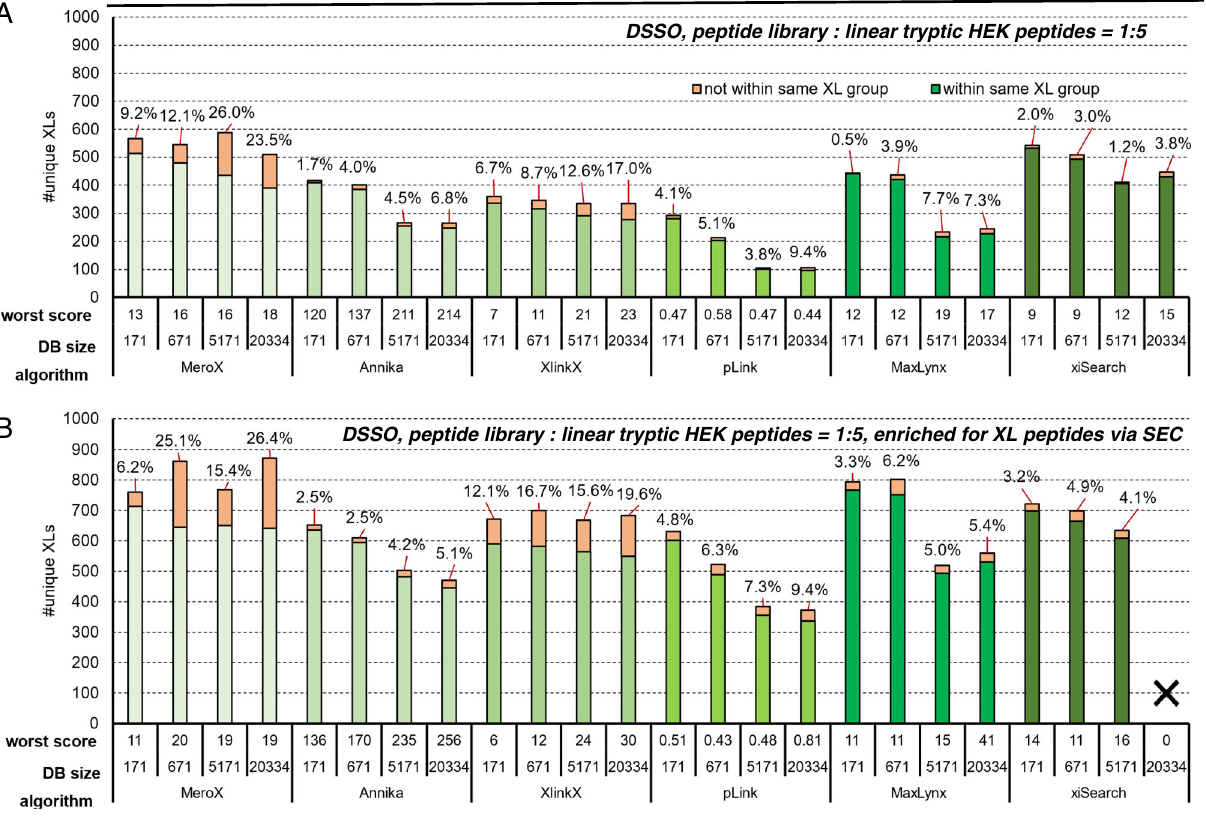
Fig. 6 Performance benchmarking in a mimicked complex environment and upon increased database size. The DSSO linked main library was mixed with linear tryptic HEK peptides (1:5 w/w). Bars indicate the number of unique crosslinks after acquisition using a stepped HCD MS2 strategy and identi fi ed using the indicated algorithm at 1% estimated FDR when using databases containing exclusively 171 E. coli ribosomal proteins, or additional 500, 5000, or 20163 human proteins. A direct measurement ( B ) measurement after enrichment for crosslinked peptides by size exclusion chromatography. Of note, analysis of the 5 SEC fractions did reproducibly not work with our largest 20334 protein database and xiSearch, as the software crashes. This data is therefore missing. Source data are provided as a Source Data fi